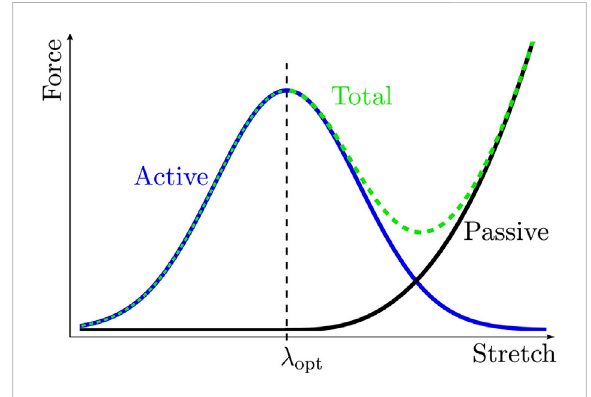
FIGURE 2 Force-Stretch relation for a muscle. λ opt is the stretch where the muscle exerts its maximum force, decreasing or increasing stretch will produce a drop in the generated force. During active response, the maximum isometric tension σ o characterizes the maximum force, and the active stretch λ a characterizes stretch; whereas during passive response, the stretch of collagen fi bers (cid:2) I 4 characterizes